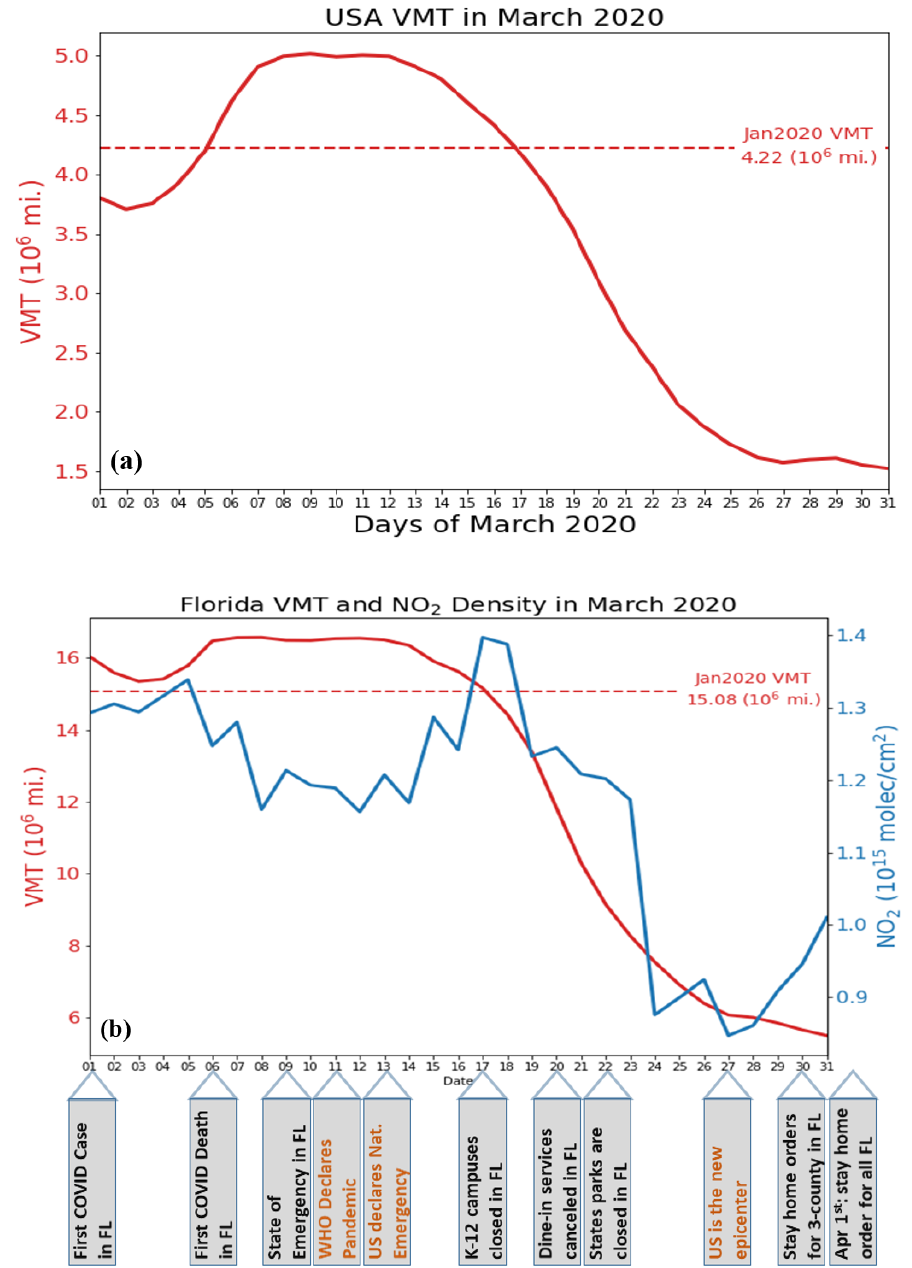
Figure 4. Seven day moving averages of vehicle mile traveled (VMT) in the U.S. ( a ) Seven day moving averages of VMT and NO 2 concentration in Florida ( b ).